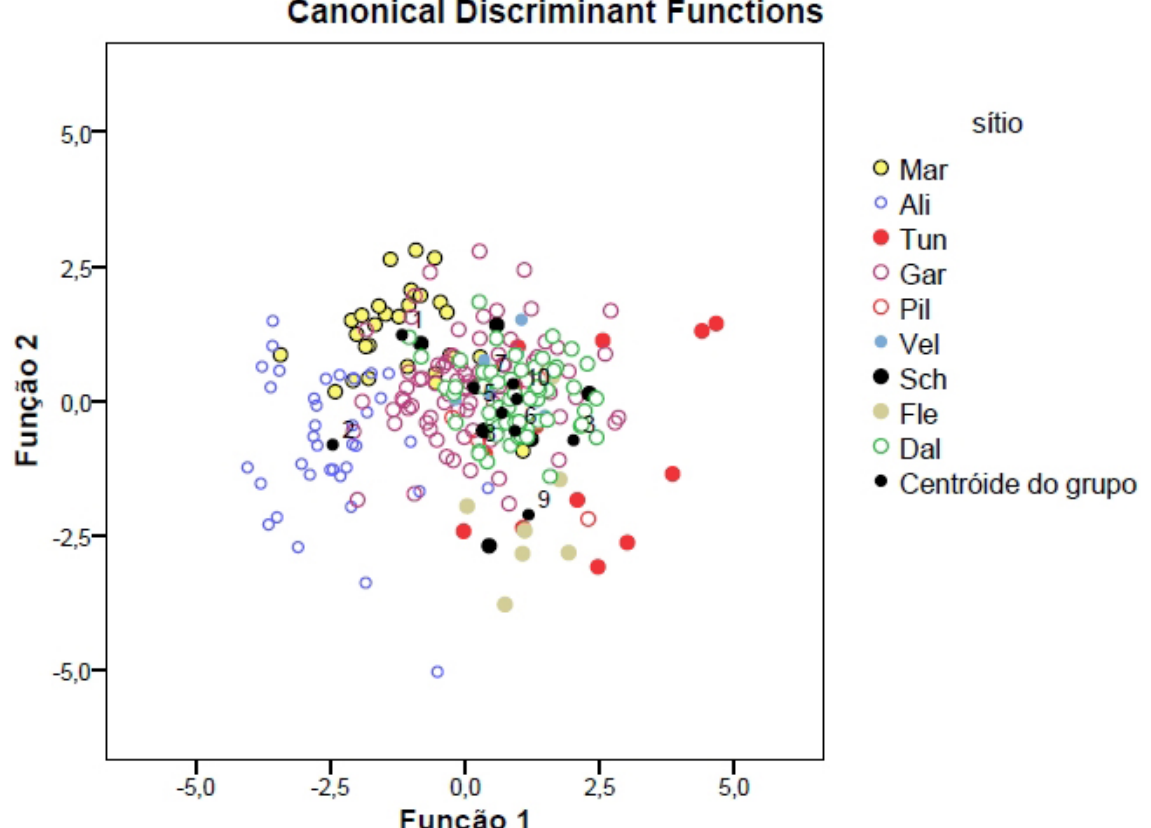
Figura 5. Gráfico da Função 1 x Função 2 da Análise de Funções Discriminantes com base na matriz de “Relative Warp Scores”. Figure 5. Function 1 x Function 2 Discriminant Analysis Functions Analysis graph based on the “Relative Warp Scores”